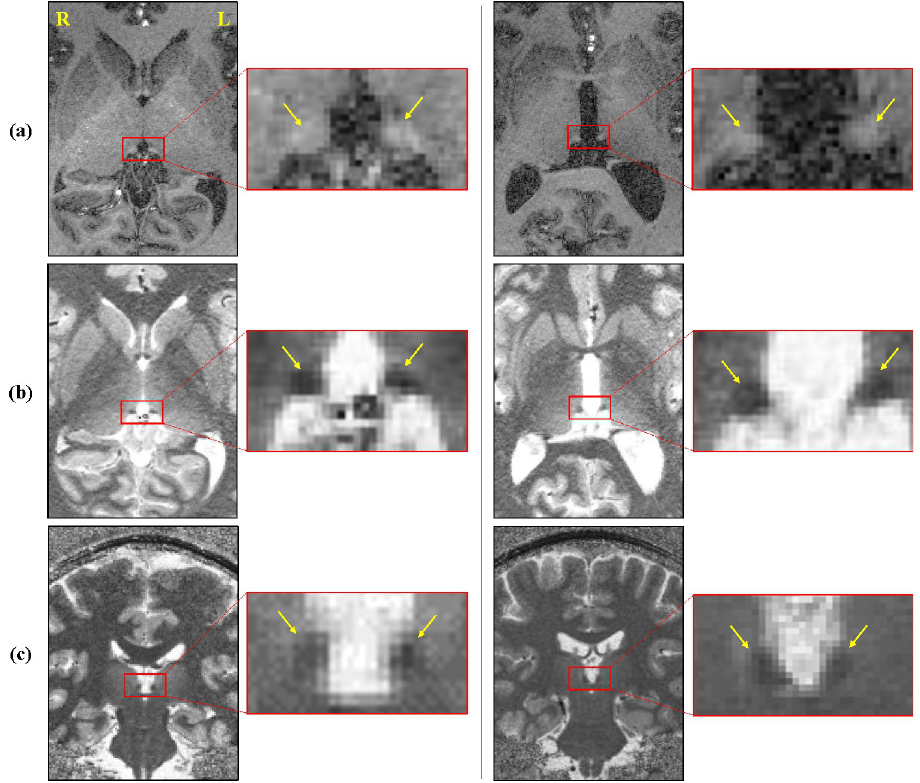
Fig 1. The habenula of an HC (left panel) and MDD patient (right panel). (a) axial MPRAGE, (b) axial view in ME-MP2RAGE T1 maps, and (c) coronal view in ME-MP2RAGE T1 maps. Compared to the surrounding tissues, the habenula has a brighter signal on the MPRAGE image and darker signal on the ME-MP2RAGE T1 map image. Overall, the contrast on the ME-MP2RAGE T1 map image is greater than that on the MPRAGE image. The yellow arrow points to the habenula, and the boundaries of the habenula are indicated by the yellow dotted line. Abbreviations: HC, healthy control; MDD, major depressive disorder; ME-MP2RAGE, multi-echo magnetization- prepared 2 rapid gradient echoes; MPRAGE, magnetization-prepared rapid gradient echo.